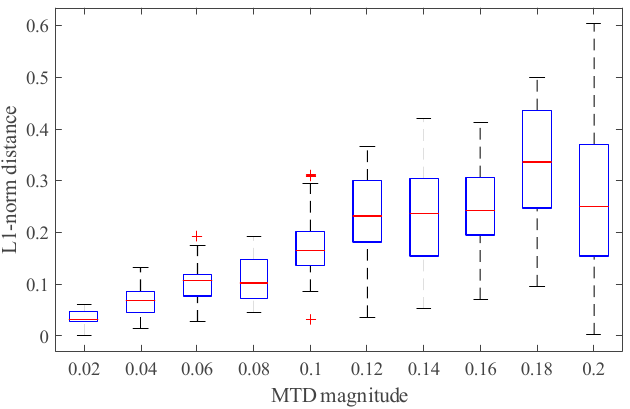
Figure 6. L1-norm distance under MTD magnitudes.